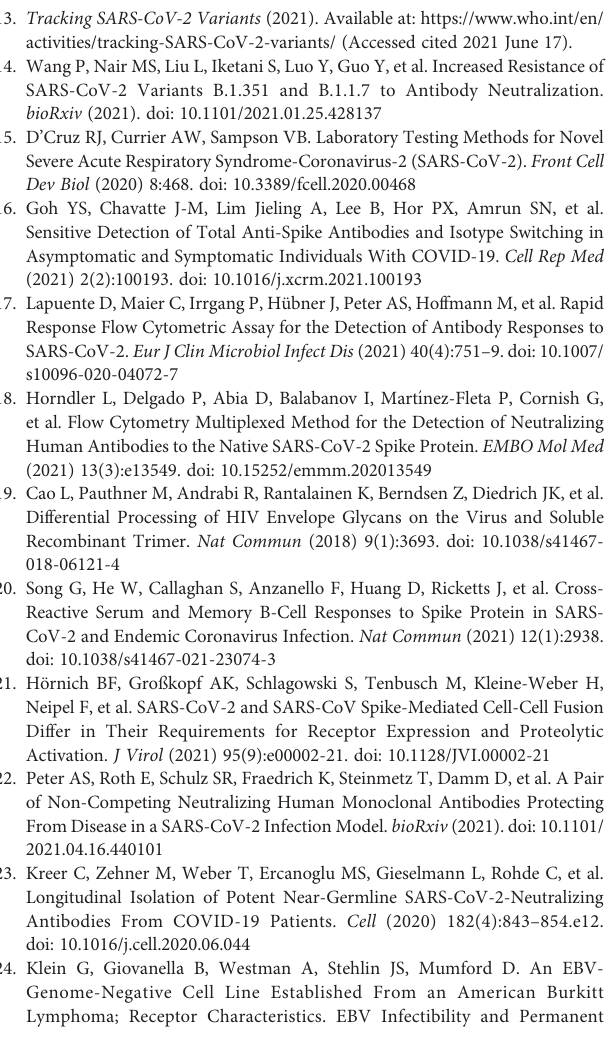
Supplementary Figure 1 | SerumIgG (left) and IgA (right) response in 12 persons before receiving the fi srt dose of the BioNTech/P fi zer mRNA vaccine. Evaluation of the binding to Ramos cells expressing either the WT (green), the alpha variant (blue) or the beta variant (red) S protein. (A) or Ramos cells expressing RBD-CD8 protein with either a WT (green), or an N501Y (blue), E484K (red) or G496I (grey) mutated RBD sequences (B) . Shown are normalized mean fl uorescence intensity (MFI) values. Supplementary Figure 2 | ELISA study for IgG-class anti-S1 antibodies in the sera of 12 persons vaccinated with the BioNTech/P fi zer mRNA vaccine and tested before (black), after the fi rst (orange) or the secondary vaccination (green). Shown are the measure values related to the calibrator (measured value/calibrator). Supplementary Figure 3 | Flow cytometric analysis of the expression of the RBD-CD8 variants on Ramos Null cells stained with anti-mouse CD8 antibodies, mAb TRES224, serum IgG of the individuals C1 and